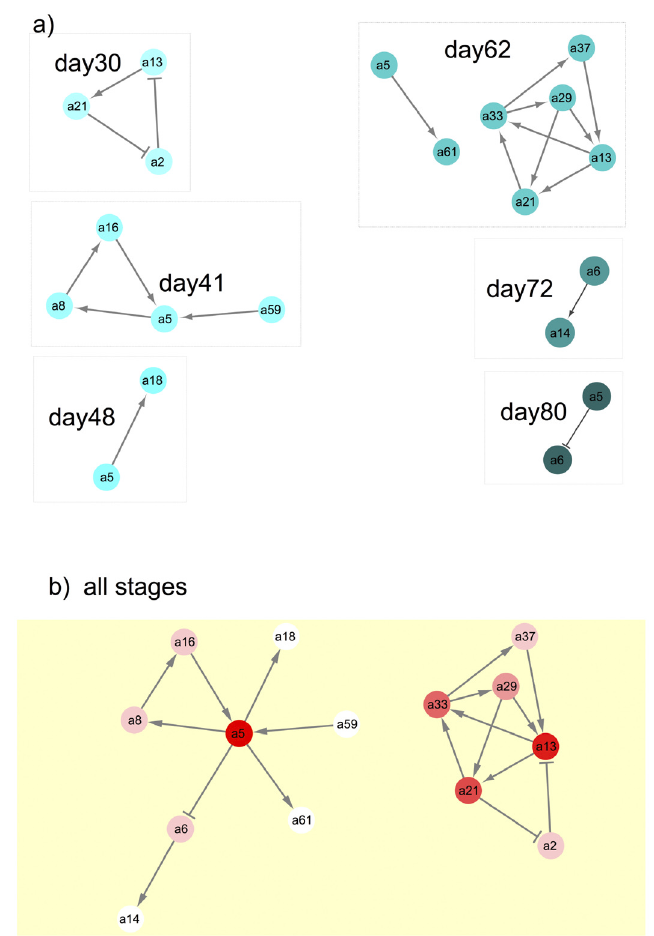
Figure 4. Network visualization of significantly co-occurring ribotype OTU pairs at each plant stage, with the identifier number for each OTU shown with the label “a” plus the number. If there were no significant co-occurring OTU, then that sample stage was not shown. Negative interactions between OTU nodes are shown as edges with a barred arrow tip and positive correlations between OTU are indicated with pointed arrows. a ) Significant co-occurring OTU from each sampled stage. b ) Results of DyNet analysis of co-occurring OTU most changed across stages. Only significant co-occurring OTU (as shown in part a) were analyzed using DyNet. Intensity of the red color of nodes indicates amount of change across stages, with darker color indicating the most ‘rewiring’ across